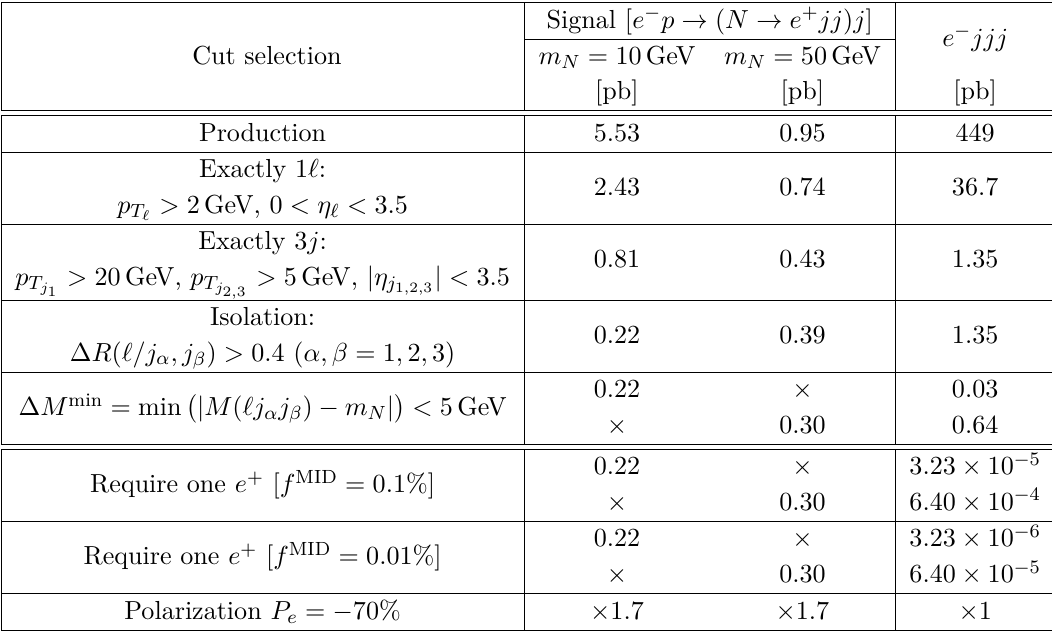
Table 2 . Cut-flow table of the Majorana HNL signal, with | U e | 2 = 1 in the e + + 3 j final state. The last row indicates the cross-section enhancement factor for a P e = − 70% polarized electron beam. Similarly for the tables